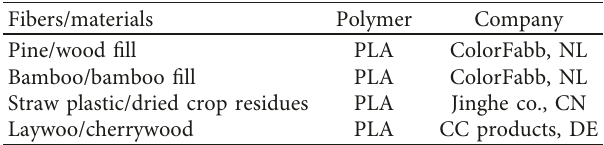
Table 14: Commercially available PLA-based filaments